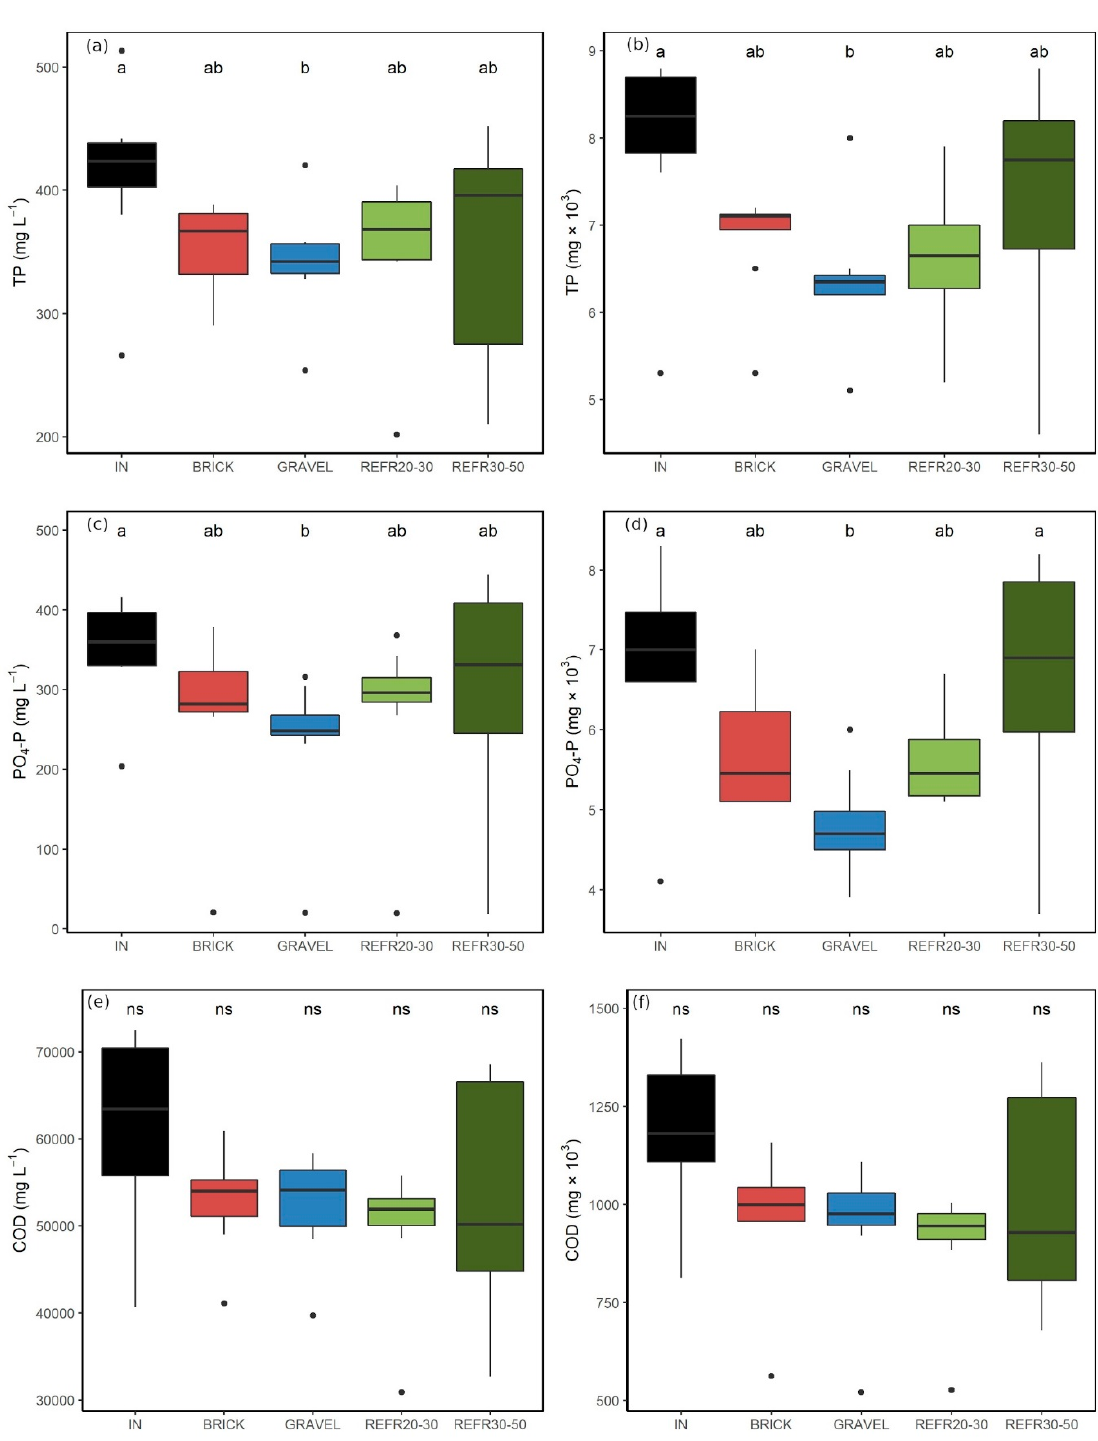
Figure 3. Box plot of total phosphorus (TP), soluble phosphorus (PO 4 -P), and chemical oxygen demand (COD) expressed as concentration ( a , c , e ) and mass balance ( b , d , f ). Different letters indicate significant differences according to a Kruskal–Wallis test with p ≤ 0.05. ns = not significant difference.